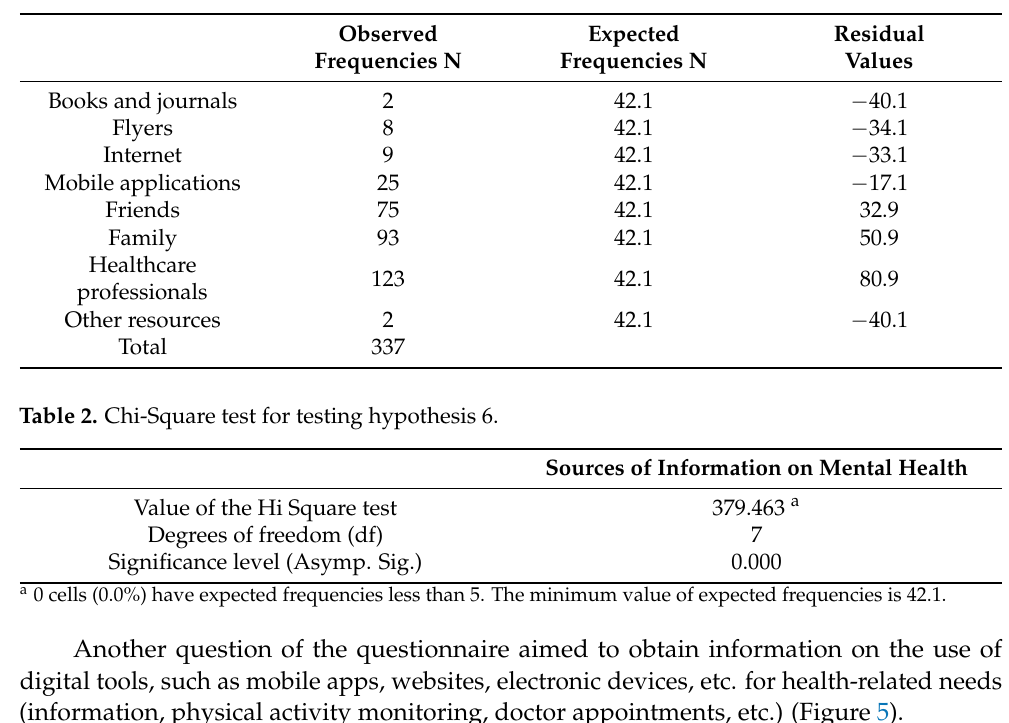
Residual Values